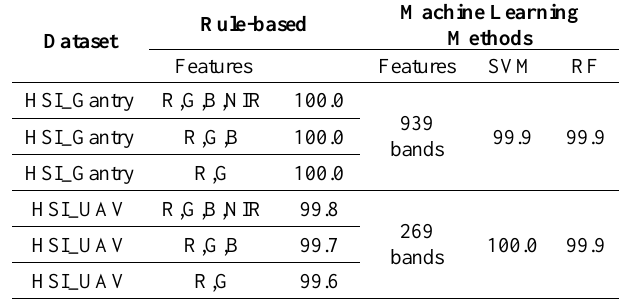
Table 2. Testing accuracies (%) of classifying HSI datasets using different